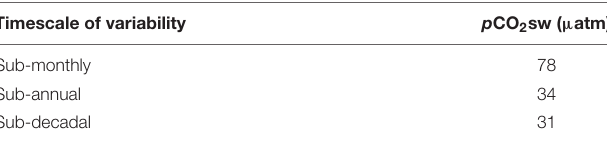
TABLE 4 | Amplitude of p CO 2 sw variability at CRIMP-2 on different time scales, defined as the average standard deviation of monthly, annual and 4-year mean p CO 2